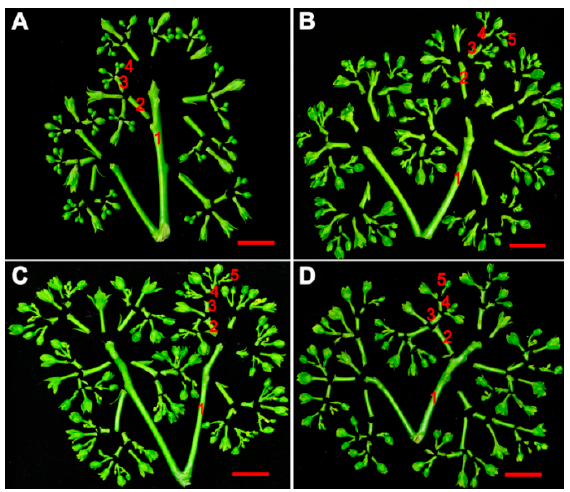
Figure 4. Comparison of inflorescence branching in the JcDAD1 -RNAi transgenic plants with that in the wild type (WT) plants. The graph depicts inflorescence branching in WT plants ( A ) and the transgenic lines L2 ( B ), L3 ( C ), and L10 ( D ). The numbers (1–5) represent different orders of branching. Bars = 2.0 cm.